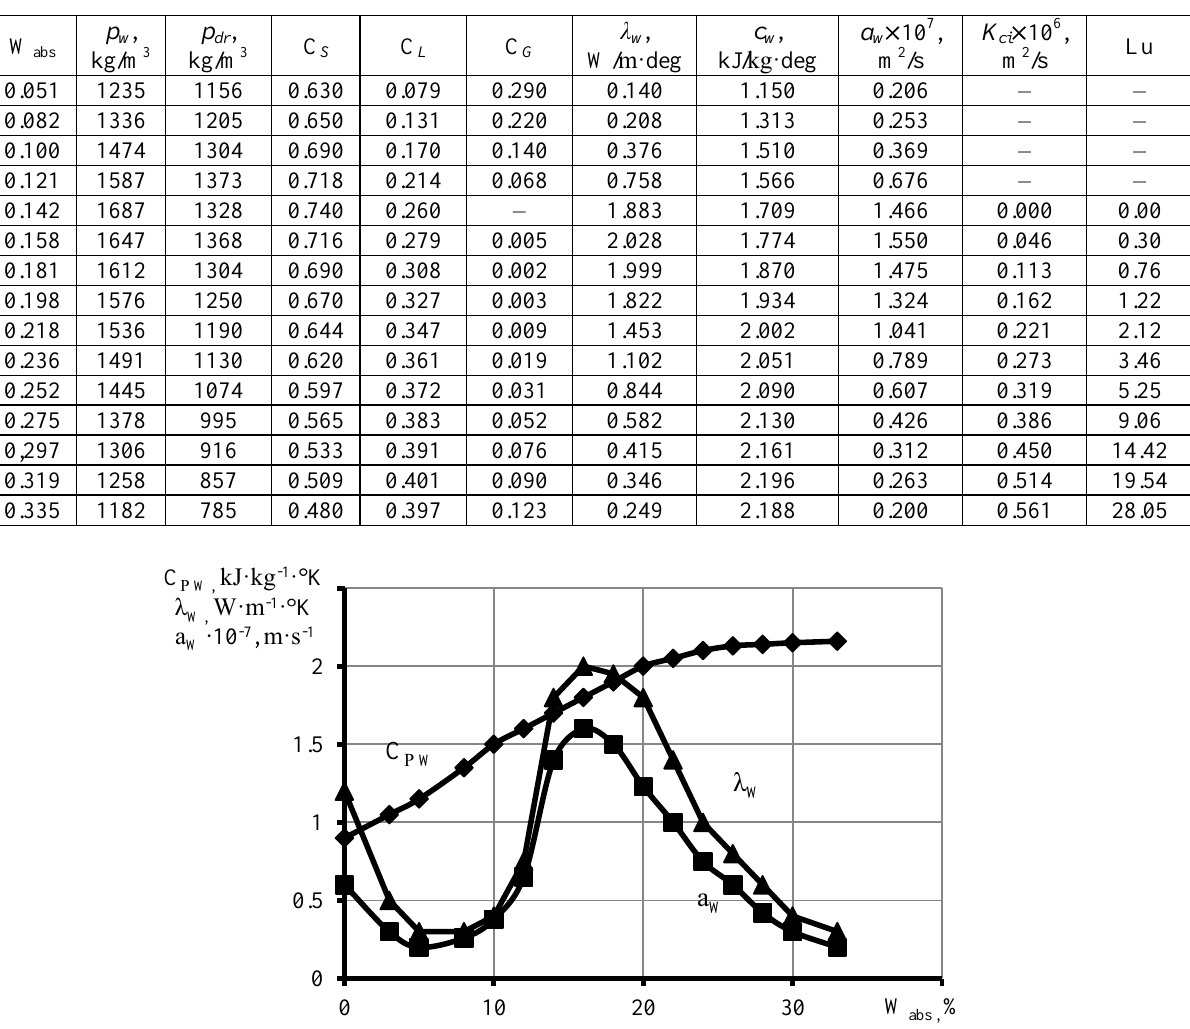
Fig. 1. Relation between thermophysical properties and moisture content of